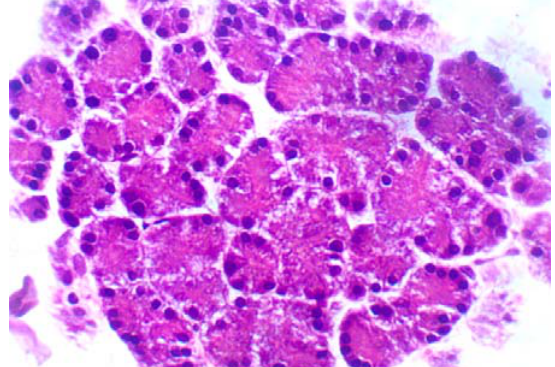
Fig. 3. The Syrian hamster's pancreas that received a diet rich in fats and fructose. Hypertrophy and hyperchromia of nuclei, a distinct increase in the zymogen-retaining zone, vacuolation of the cytoplasm of pancreatitis. He- matoxylin-eosin. ×200 Morphometrically, the number and percentage of small islands, their area recovered to almost the level of intact control. A clear tendency towards the restoration of the share of middleware has been traced (Table 1). In the exocrine part, sometimes acino-islet cells are seen – mixed cells that produce both zymogen granules and hormones simultaneously (Fig. 4).